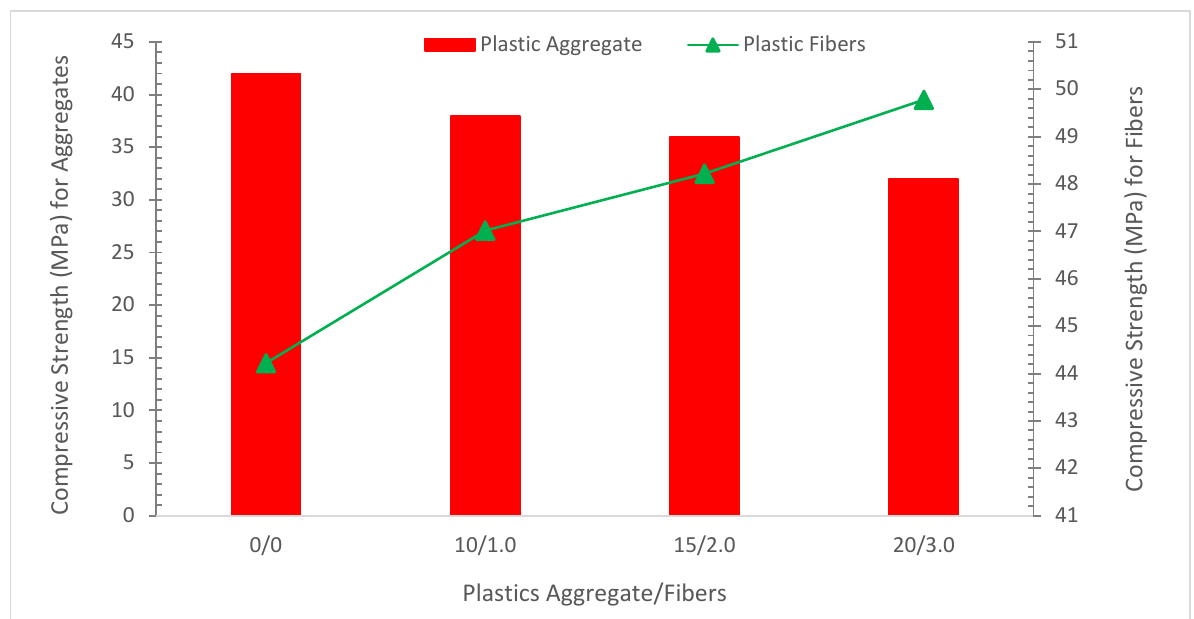
Figure 6. Compressive Strength: Data Source [24,26].